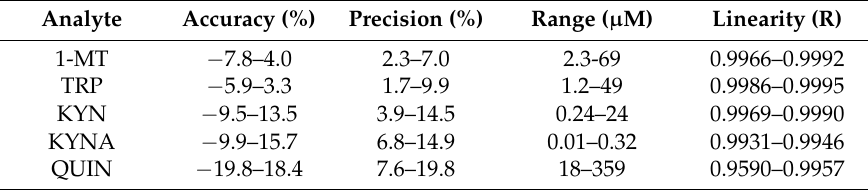
Table 3. Analytic quality parameters for 1-MT, TRP and its